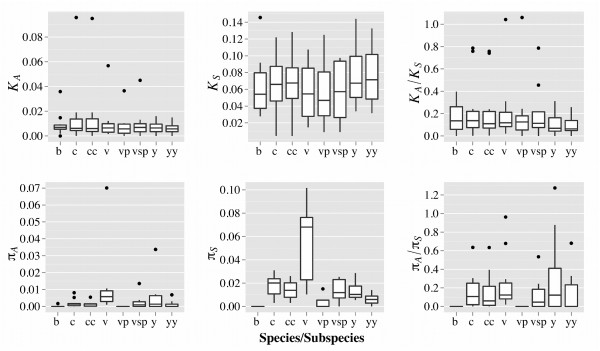
Divergence and polymorphism in rodent malaria parasites. Boxplots were constructed using values obtained for each of the 11 nuclear loci (Additional files
7,
10) and represent divergence (top row) and polymorphism (bottom) at non-synonymoys sites (left; KA, πA), synonymous sites (middle; KS, πS) and their ratio (right; KA/KS, πA/πS). Estimates were obtained for: P. berghei (b); P. chabaudi (c); P. c. chabaudi (cc); P. vinckei (v); P. v. petteri (vp); P. v. subsp. (vsp); P. yoelii (y); P. y. yoelii (yy).